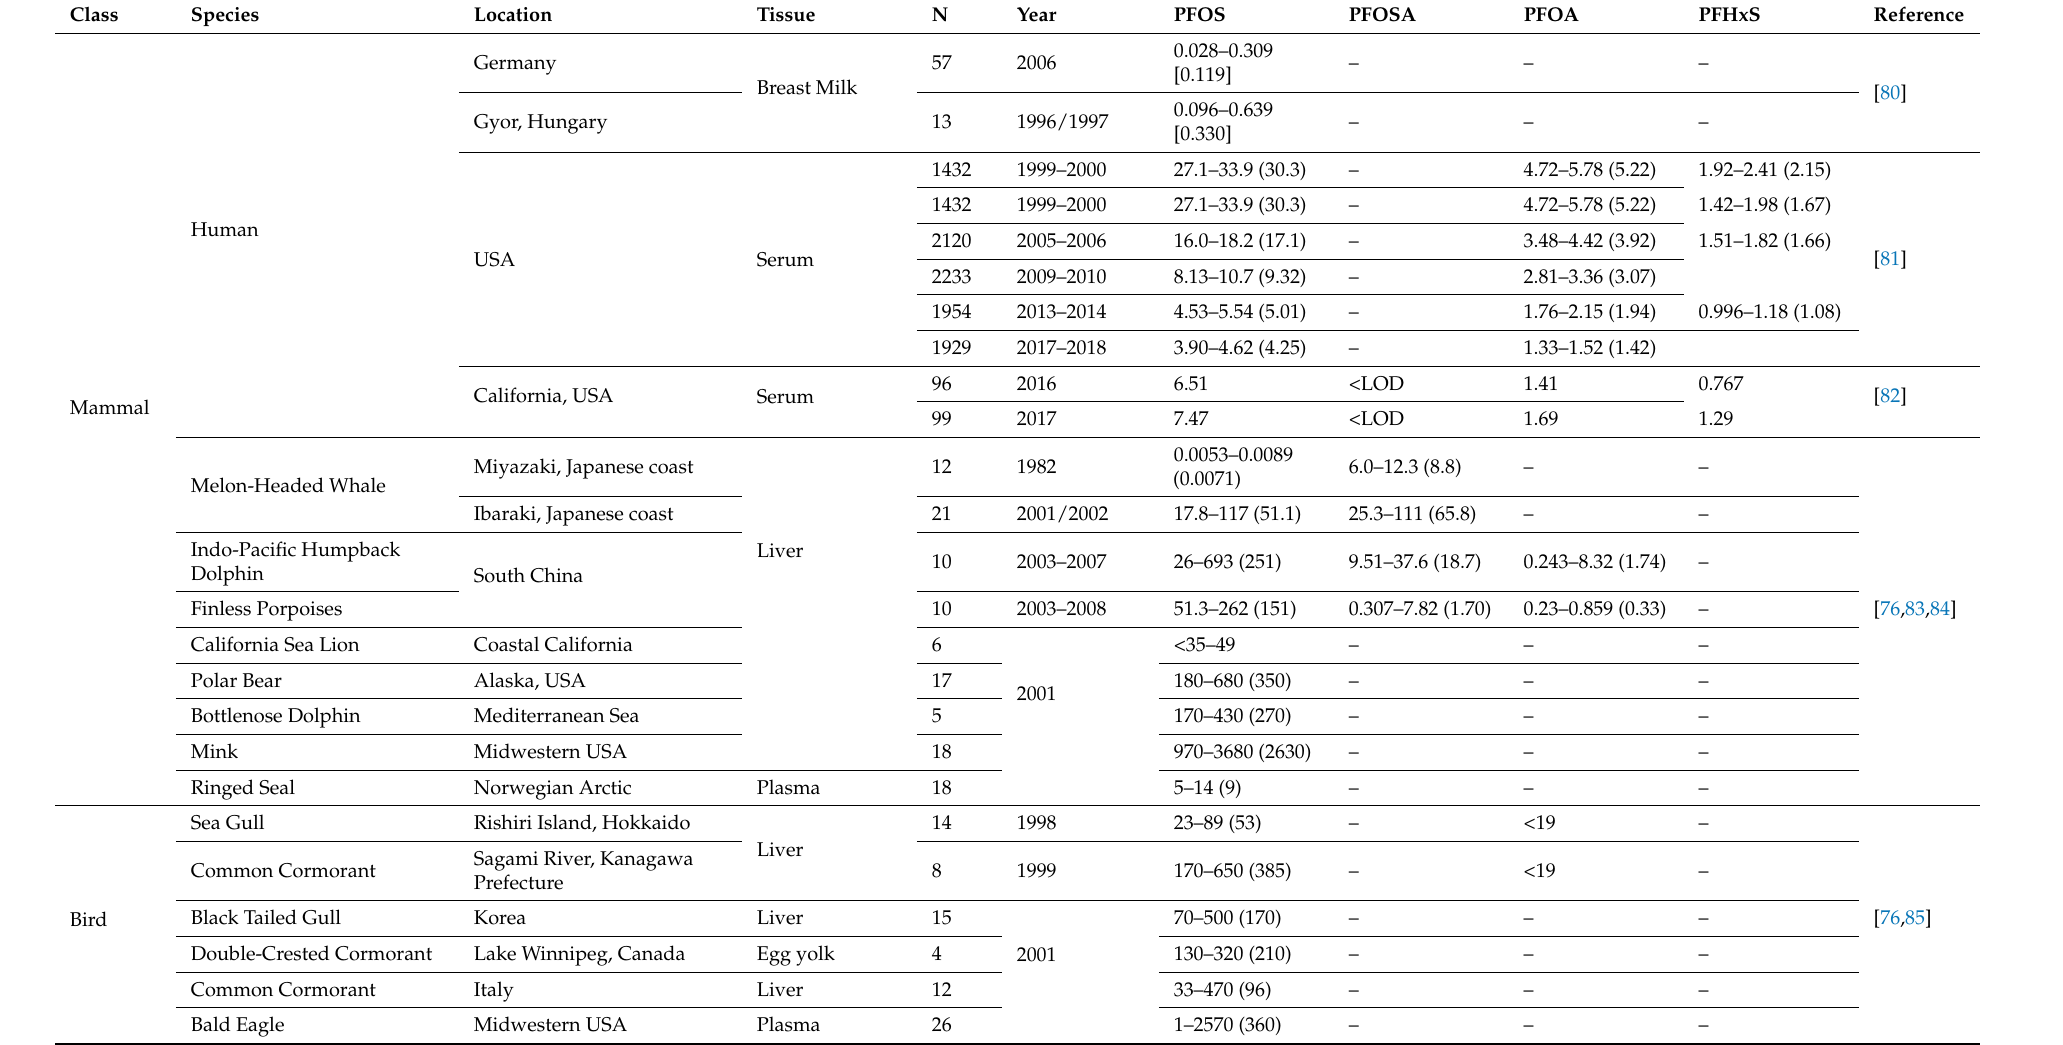
Table 2. Concentrations of some selected PFAS in organs and tissues of